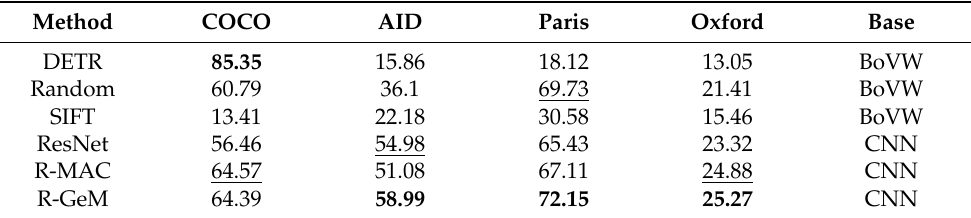
Table 1. Comparison of accuracy in a single-subject dataset. The bold and underline mean the best and second accuracy for each dataset, respectively.